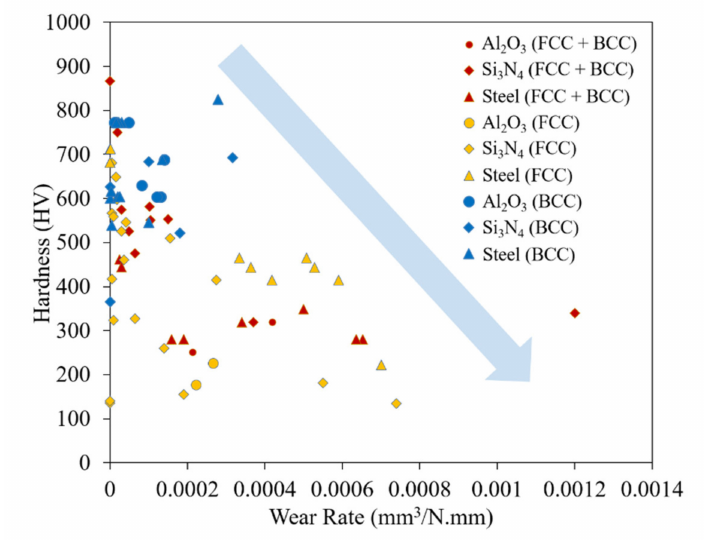
Figure 8. Hardness versus wear rate for HEAs delineated by phase